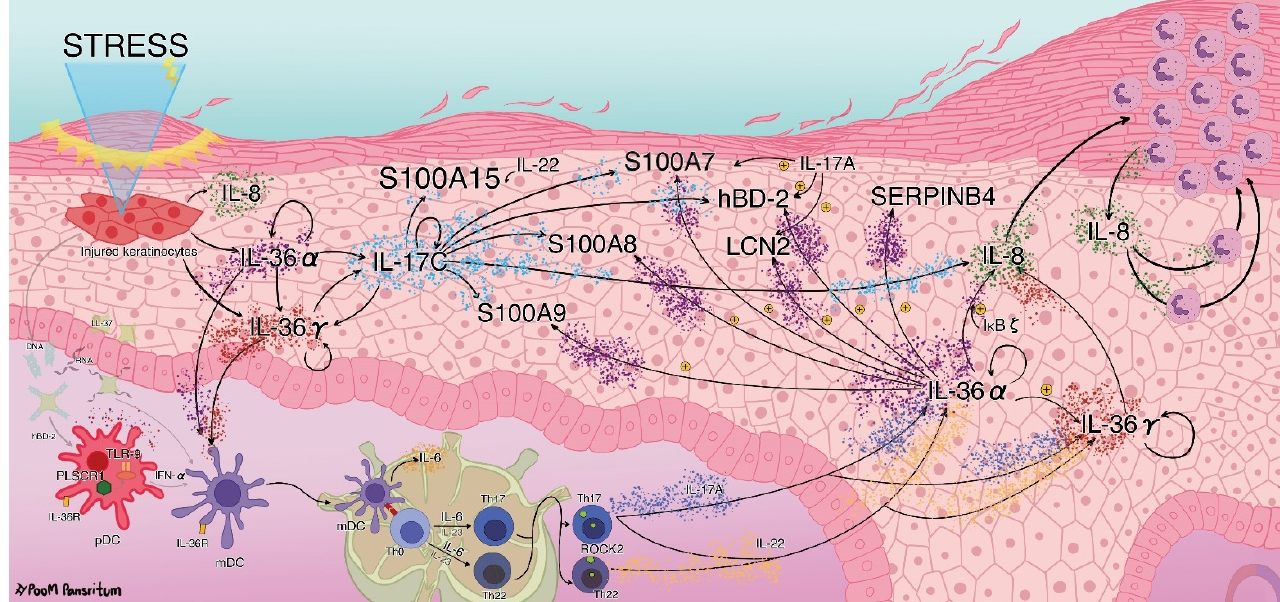
Figure 8. The proposed pathogenesis network at the peripheral edge (PE) of the lesional skin. Injured keratinocytes secrete interleukin (IL)-8, IL-36 α , and IL-36 γ . IL-36 activates plasmacytoid dendritic cells (pDCs) to secrete interferon-alpha (IFN)- α in a Toll-like receptor (TLR)-9-dependent manner (IL-36/TLR-9 axis). IL-36 α and IL-36 γ activate myeloid dendritic cells (mDCs) to mature and secrete IL-6, which drives the differentiation of T helper (h) cells (IL-6/Th17 axis). ROCK2 (rho-associated kinase 2) regulates CD4 + T cells to secrete IL-17. Note that inflammation in the PE skin is potentiated by IL-36 α , IL-36 γ , IL-17C, IL-8, S100A7, S100A8, S100A9, S100A15, SERPINB4, and hBD-2 and that a self-sustaining circuit between the innate and adaptive immune response in the PE skin is mediated through IL-36 α and IL-36 γ .